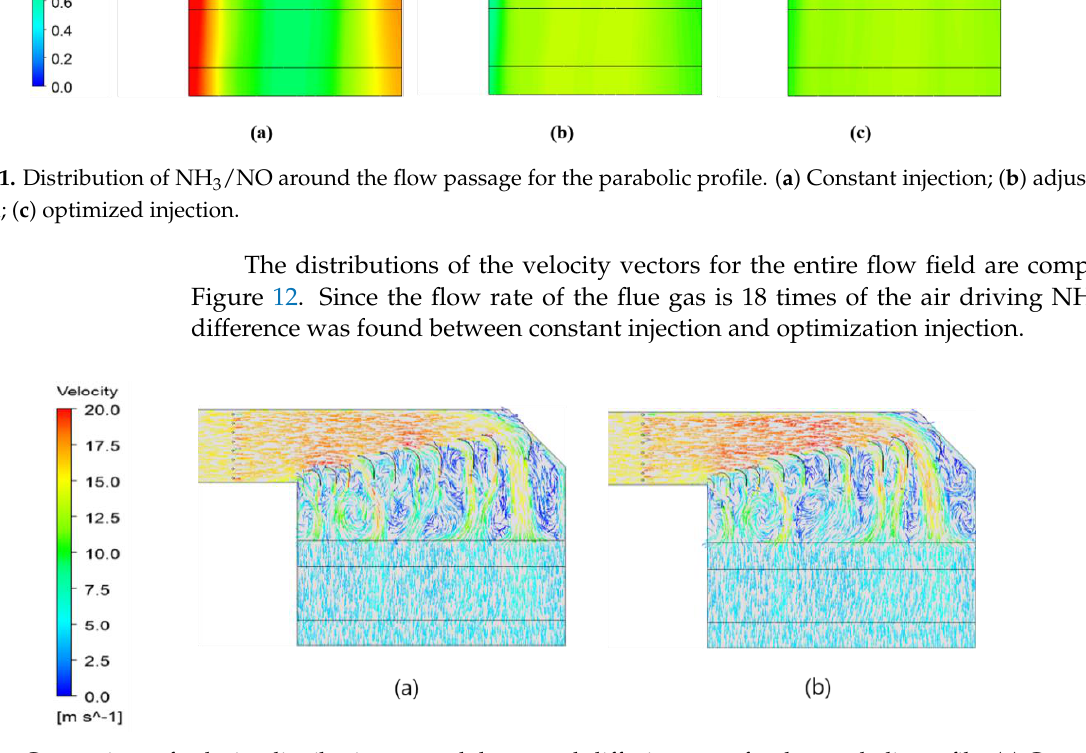
Figure 12. Comparison of velocity distribution around the curved-diffusing parts for the parabolic profile. ( a ) Constant injection; ( b ) optimized injection.